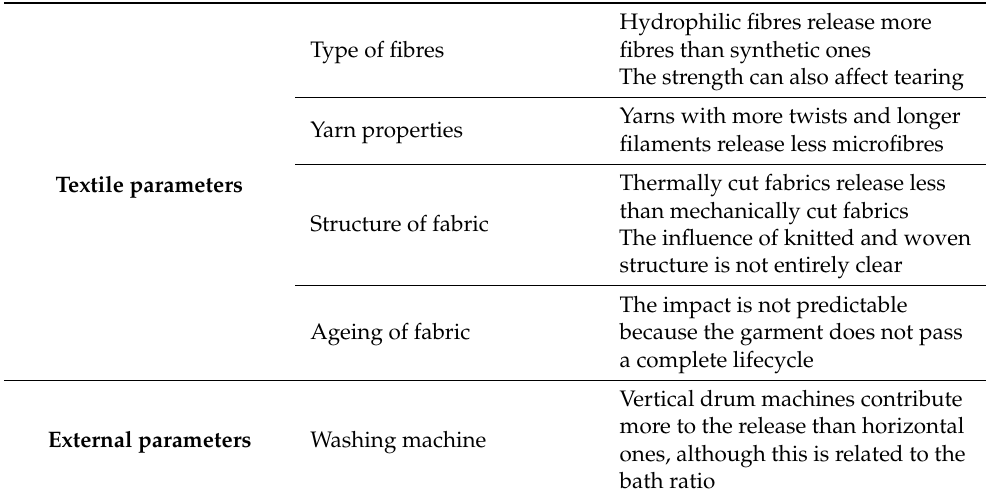
Table 2. Possibility of preventing the release of microfibers